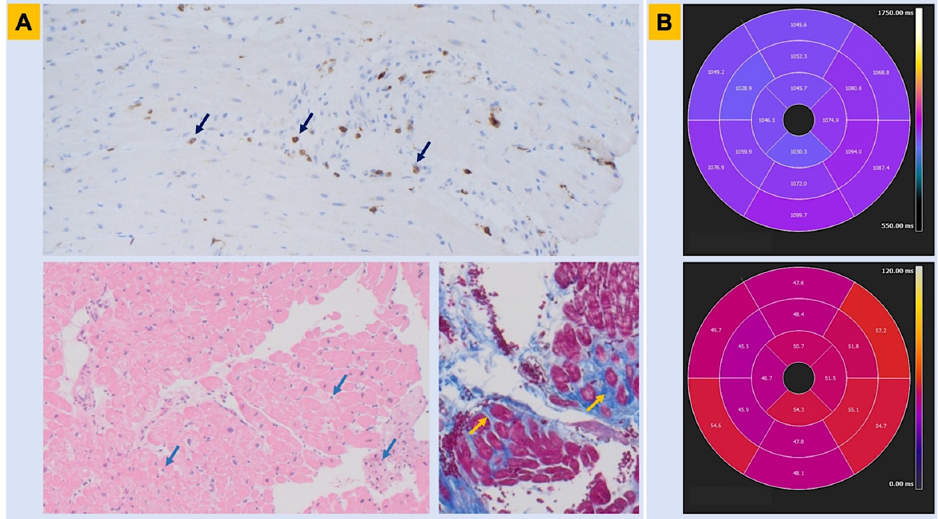
Figure 3. Histopathologic findings in Brugada syndrome. Myocardial tissue abnormalities associated with BrS are shown. Panel ( A ). Endomyocardial biopsy obtained from the right ventricle in a patient with genetically proven BrS shows lymphocytic inflammatory infiltrate with a CD3+ T-cell count consistent with myocarditis (immunohistochemistry assay—upper panel; hematoxylin-eosin assay—lower left panel; arrows). In the same patient, trichrome assay identifies areas of interstitial and replacement-type fibrosis, in blue color (lower right panel, arrows). Panel ( B ). Cardiac magnetic resonance obtained in the same patient before the automated cardioverter defibrillator implant shows abnormalities in parametric mapping involving the inferolateral left ventricular wall in both T1 and T2 sequences (n.v. for parametric mapping: T1 < 1045 ms; T2 < 50 ms). BrS = Brugada syndrome.